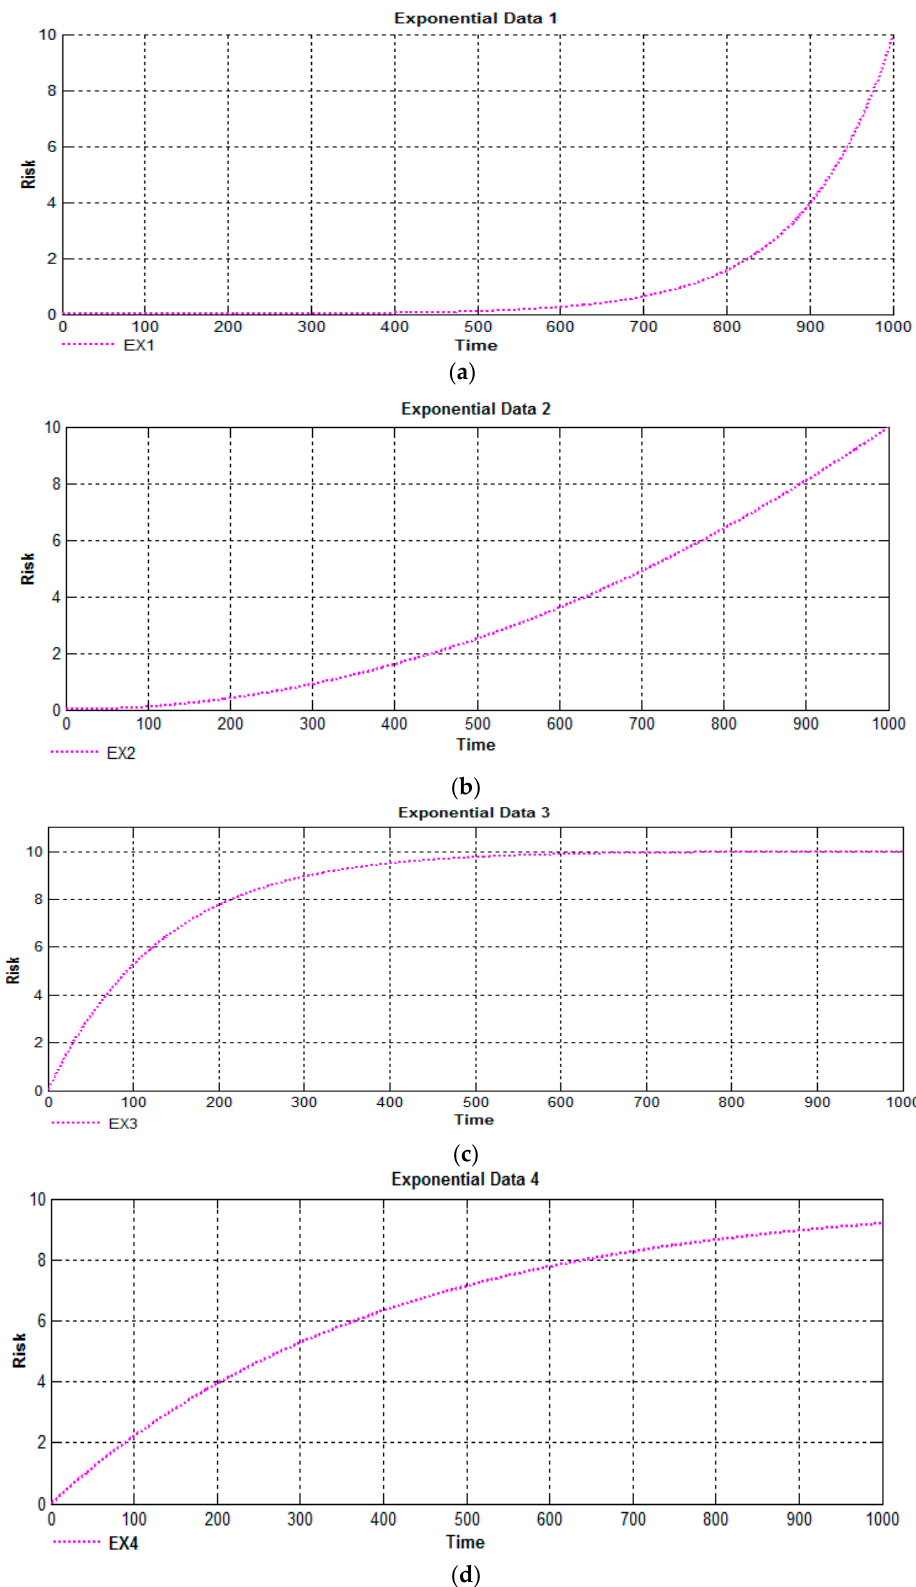
Figure 11. ( a – c ) and ( d ) represent input data generated by using different exponential equations.